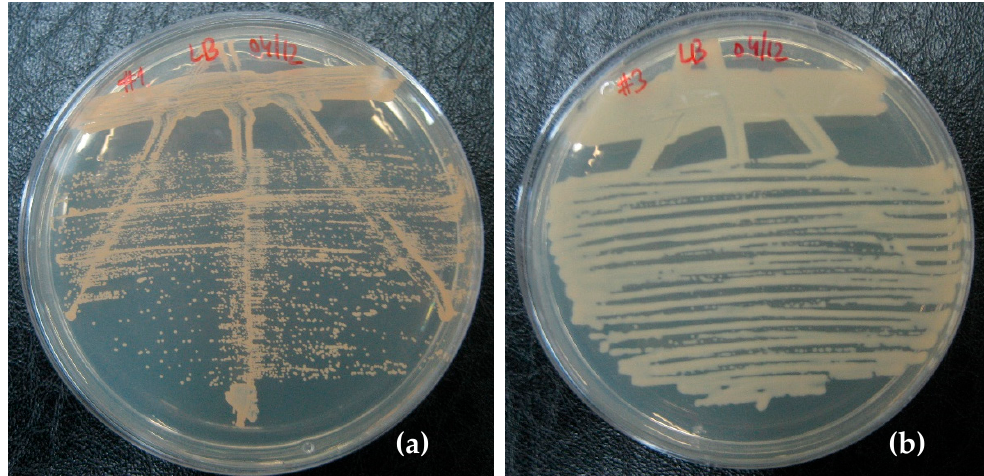
Figure 4. Bacteria isolated on LB agar plates. ( a ) Rhodococcus rhodochrous , and ( b ) Ochrobactrum anthropi bacteria.